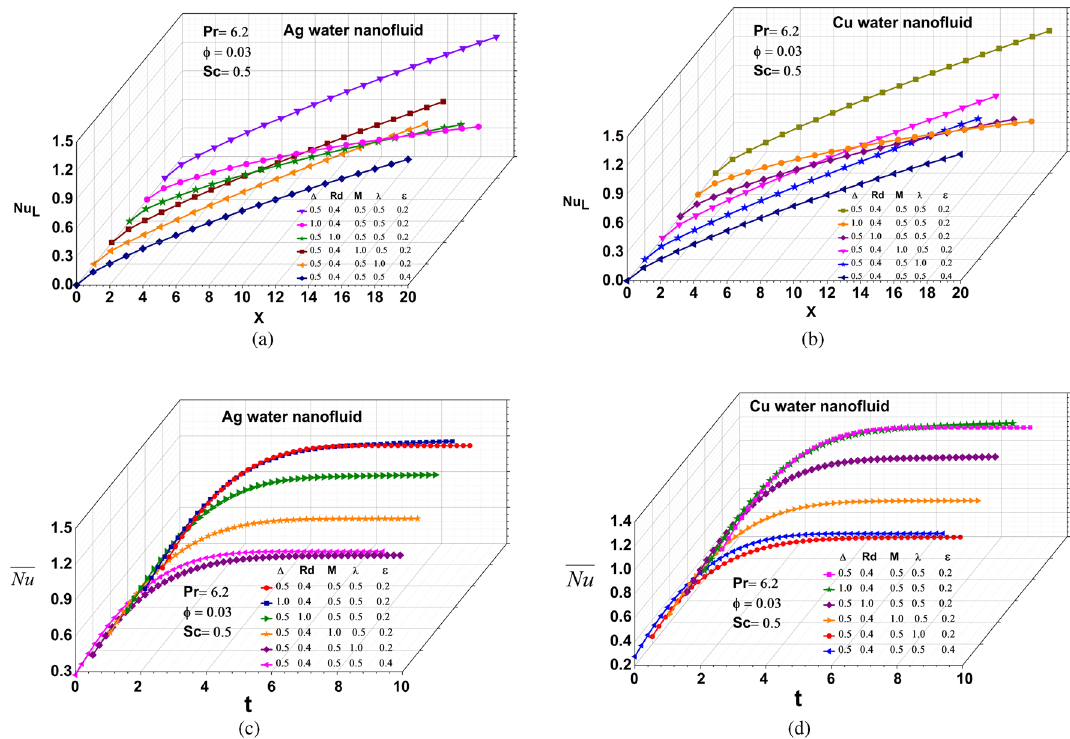
Figure 6. Local Nusselt number: ( a ) Silver ( b ) Copper , Average Nusselt number: ( c ) Silver ( d )